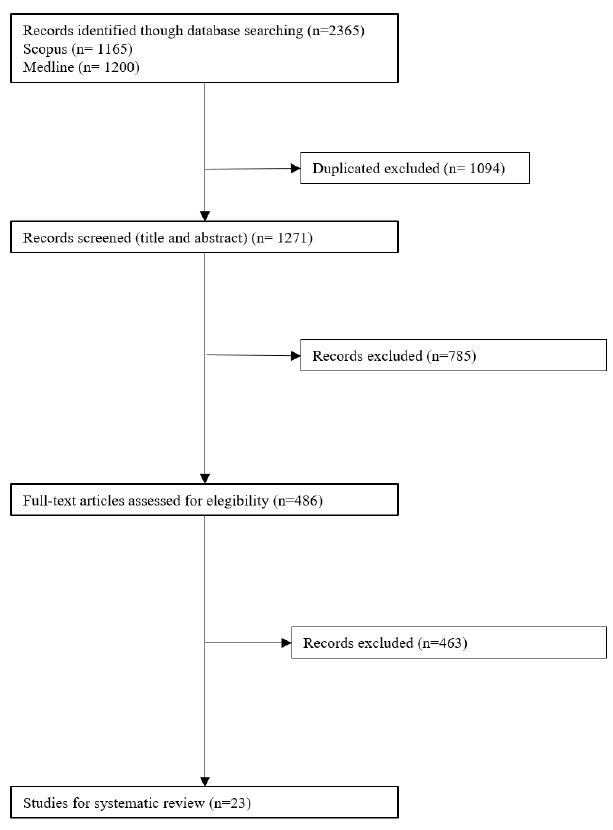
Figure 1. PRISMA flow diagram of the search strategy.